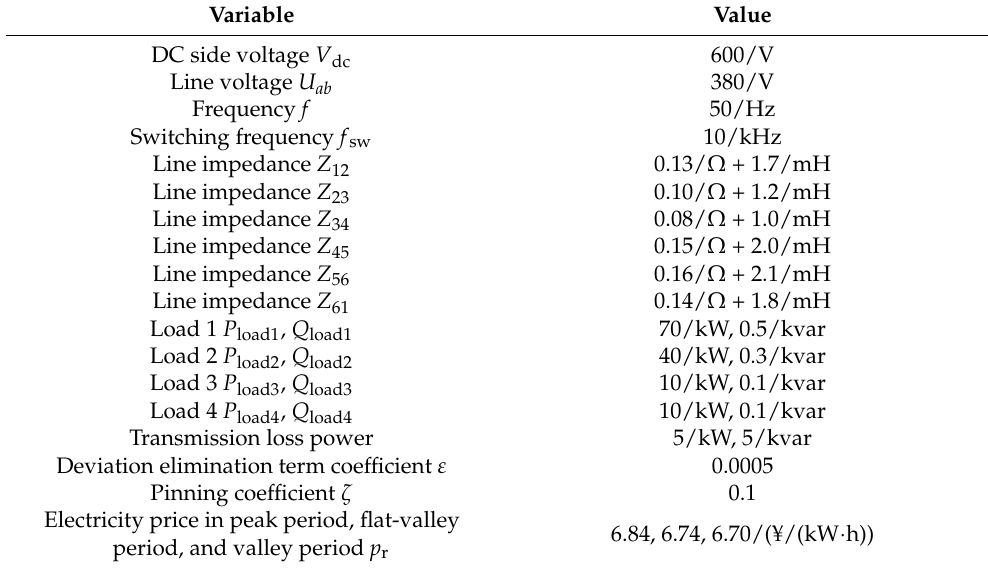
Table 2. Parameters of the system